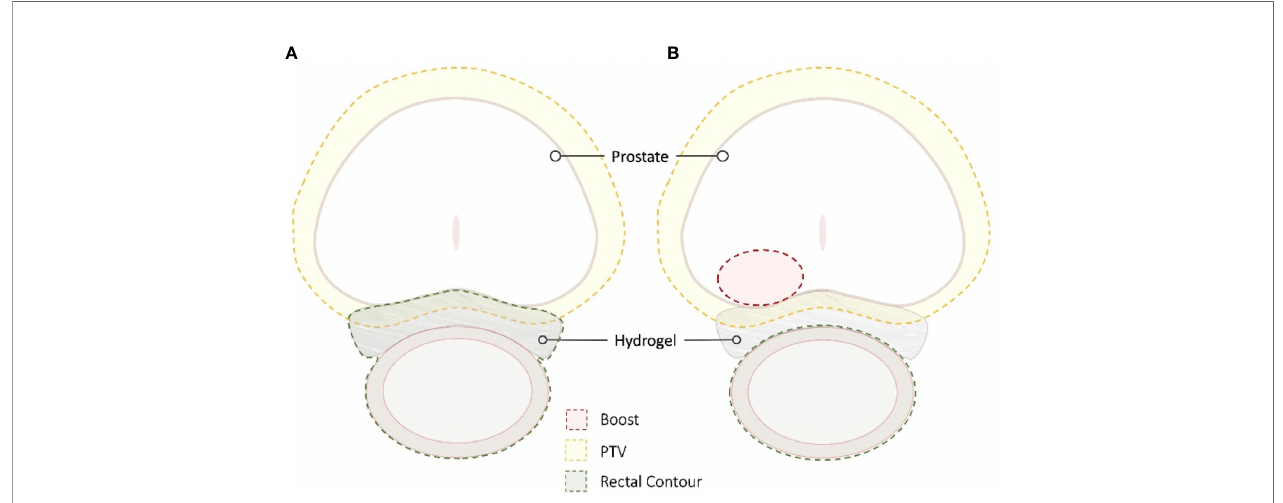
FIGURE 6 | SBRT Treatment Planning. The radiation sensitivity of the rectum in patients with in fl ammatory bowel disease is unknown; the goal is to decrease the rectal dose to as low as reasonably achievable (ALARA). For many patients, the hydrogel is incorporated into the rectal contour to maximize rectal spacing (A) . In other patients, the spacer is not incorporated to allow for dose escalation while maintaining strict rectal dose constraints (B)